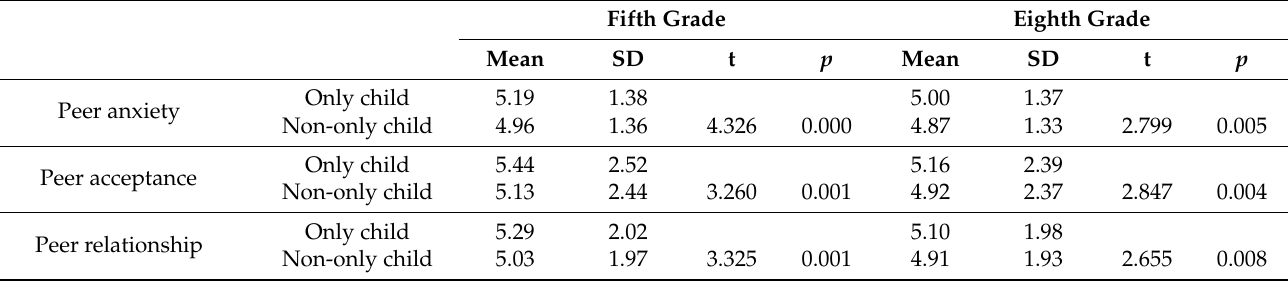
Table 14. Peer relationship dimensions after